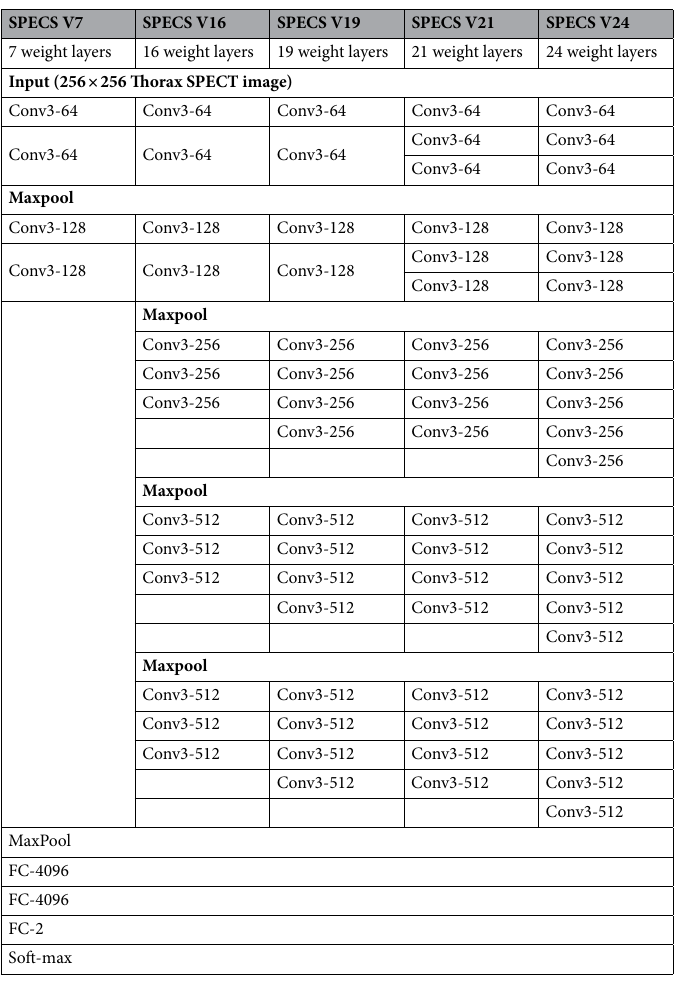
Table 3. ConvNet configuration of VGGNets. The depth of the configurations increase from the left to the right, as more layers are added. The convolutional layer parameters are denoted as “conv <receptive file size> – <number of channels>.